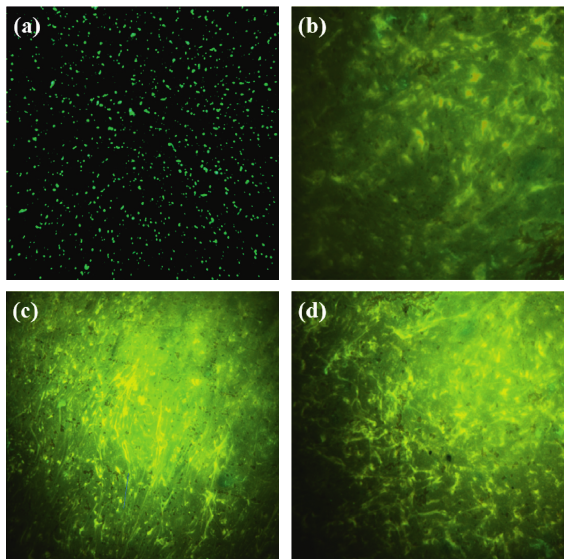
Figure 12: Fluorescence Microscopy for WEOB/SBS-modified binders with various WEOB content (a) 0%, (b) 2%, (c) 4%, and (d)